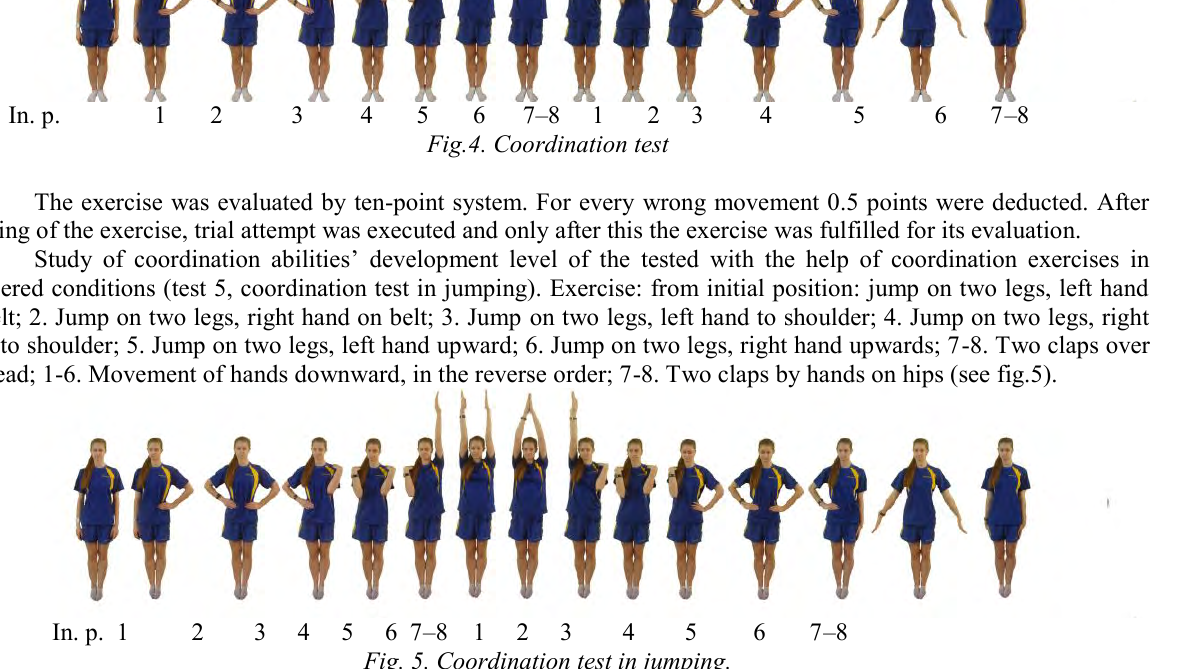
Fig. 5. Coordination test in jumping.